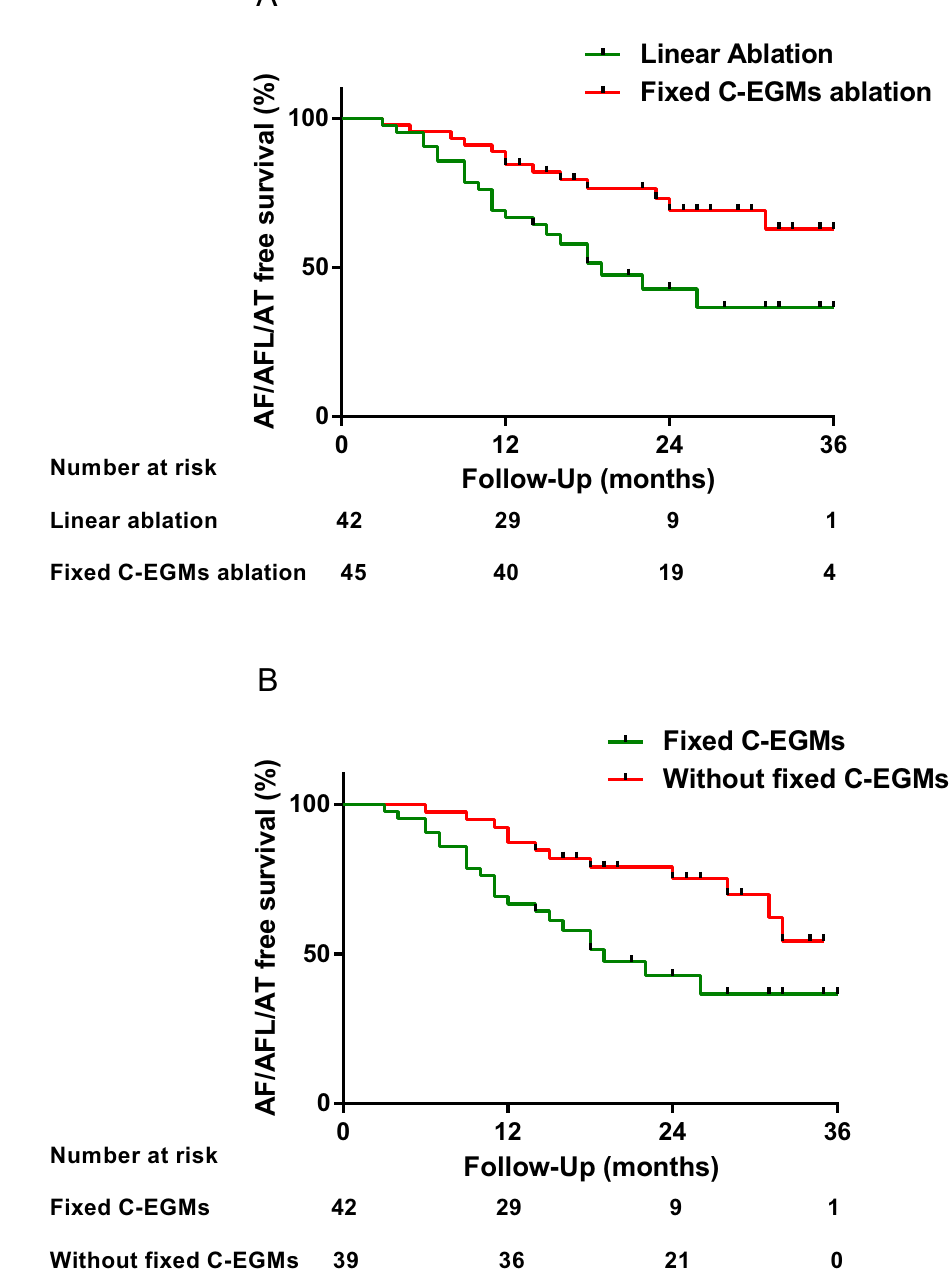
Figure 7. The Kaplan ‐ Meier curve comparing AT/AFL/AF free survival after AF ablation. ( A ) Among AF patients with fixed C-EGMs, fixed C-EGMs ablation significantly decreased incidence of recurrence compared with linear ablation (HR: 0.43; 95% CI 0.21 ‐ 0.81; P = 0.011 by log ‐ rank test). ( B ) In AF patients receiving linear ablation, patients without fixed C-EGMs were associated with a lower relative risk for recurrence (HR: 0.41, 95% CI 0.20–0.79, P = 0.009 by log ‐ rank test). AF, atrial fibrillation; AFL, atrial flutter; AT, atrial tachyarrhythmia; C-EGMs, complex electrograms in sinus rhythm; CI, confidence interval; HR, hazard